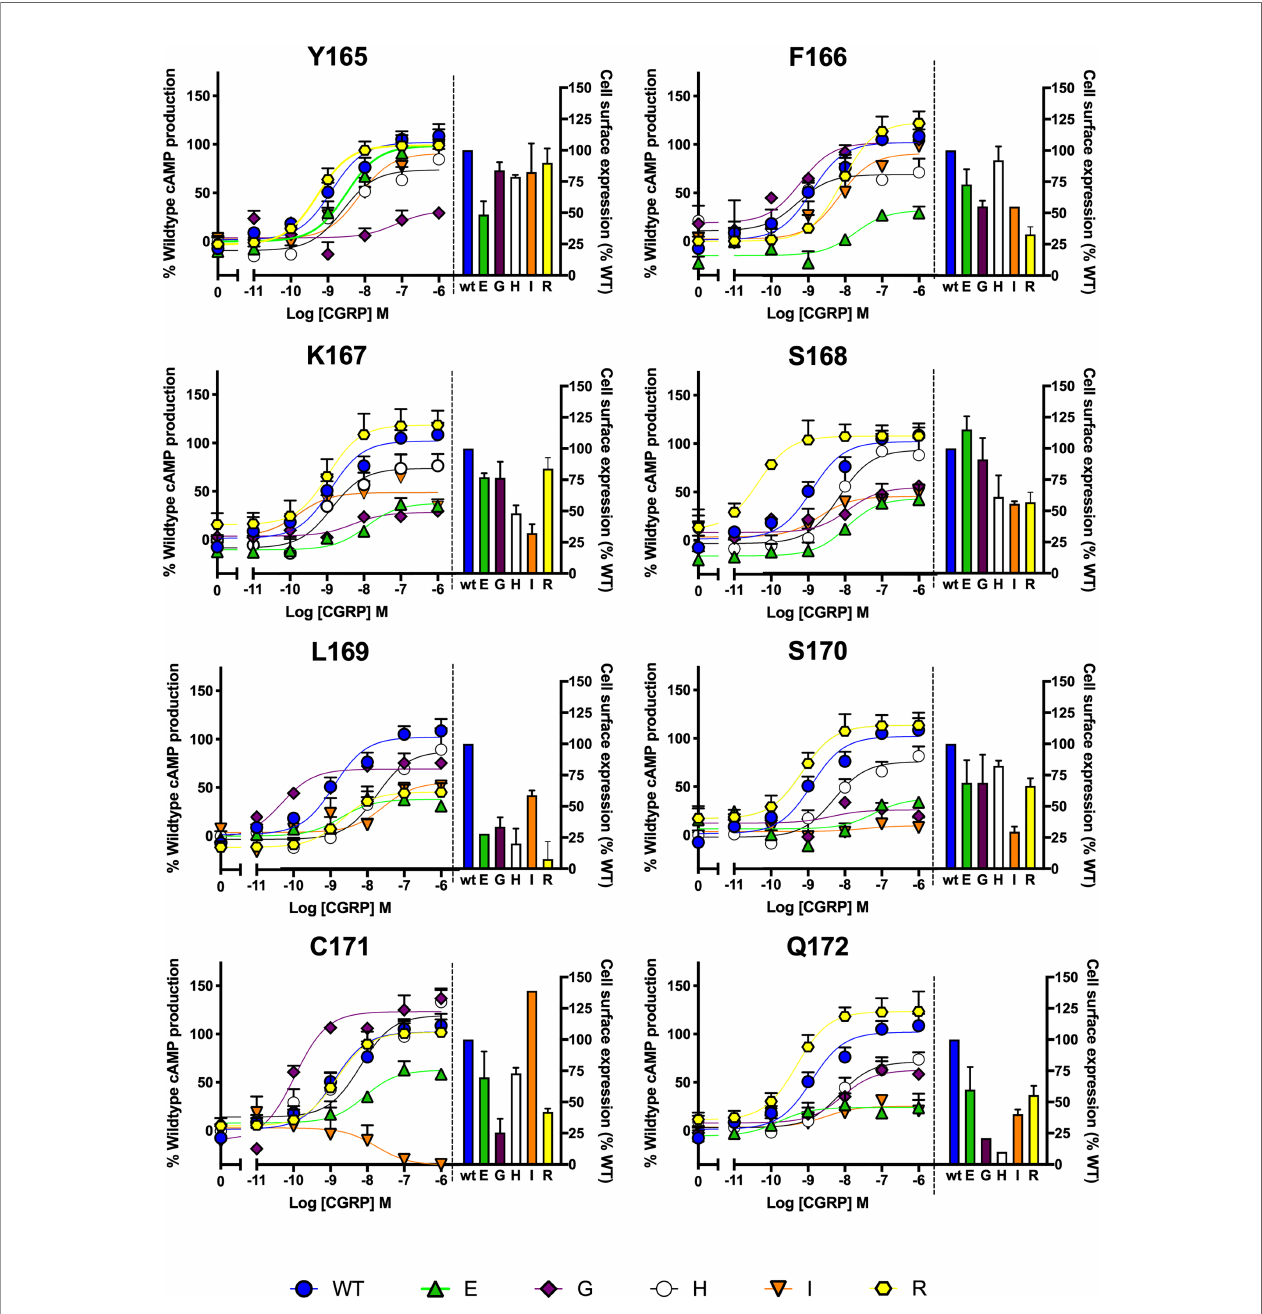
FIGURE 5 | Mutagenic analysis of residues in ICL1 at the CGRP receptor. Residues in the ICL1 were mutated to a wide range of non-complementary amino acids (as indicated) and the effects on cAMP production compared to wild type receptor (concentration-response curves). Cell surface expression for each mutant was quanti fi ed and normalized to the wild type receptor. All data are mean ± SEM of n repeats where n=minimum of 3